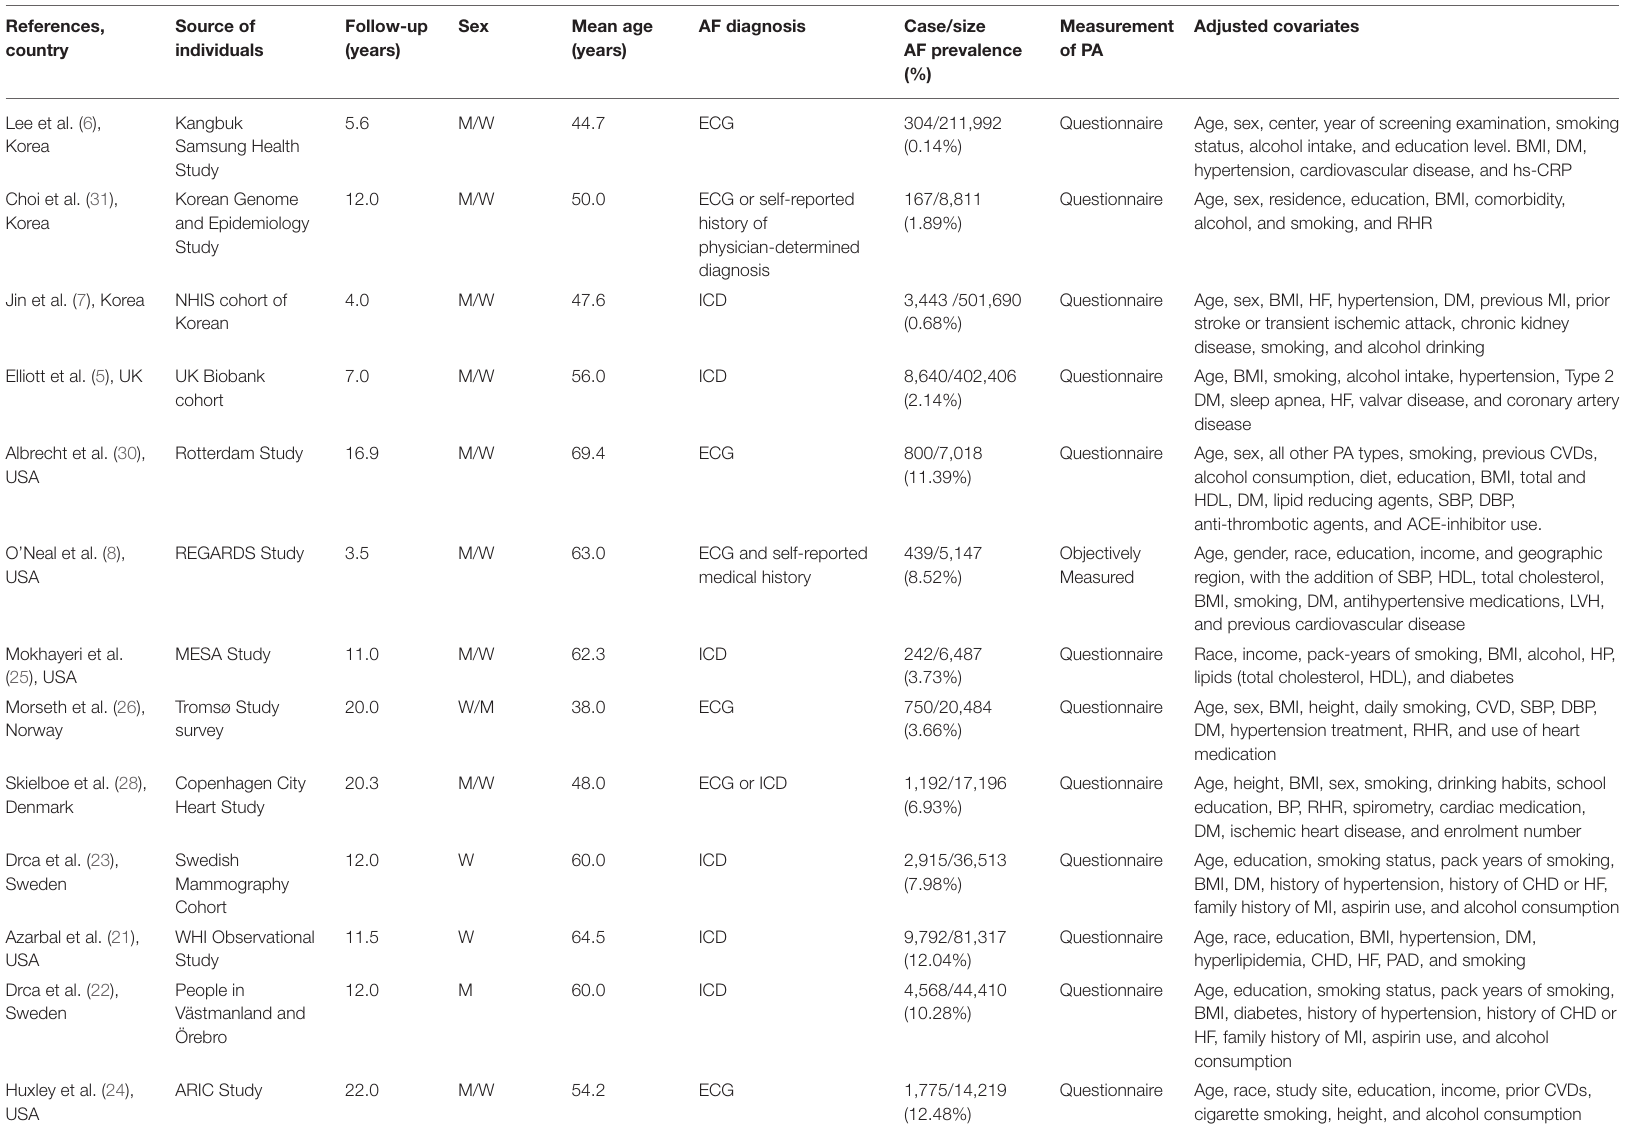
TABLE 1 | A summary of basic characteristics of the included